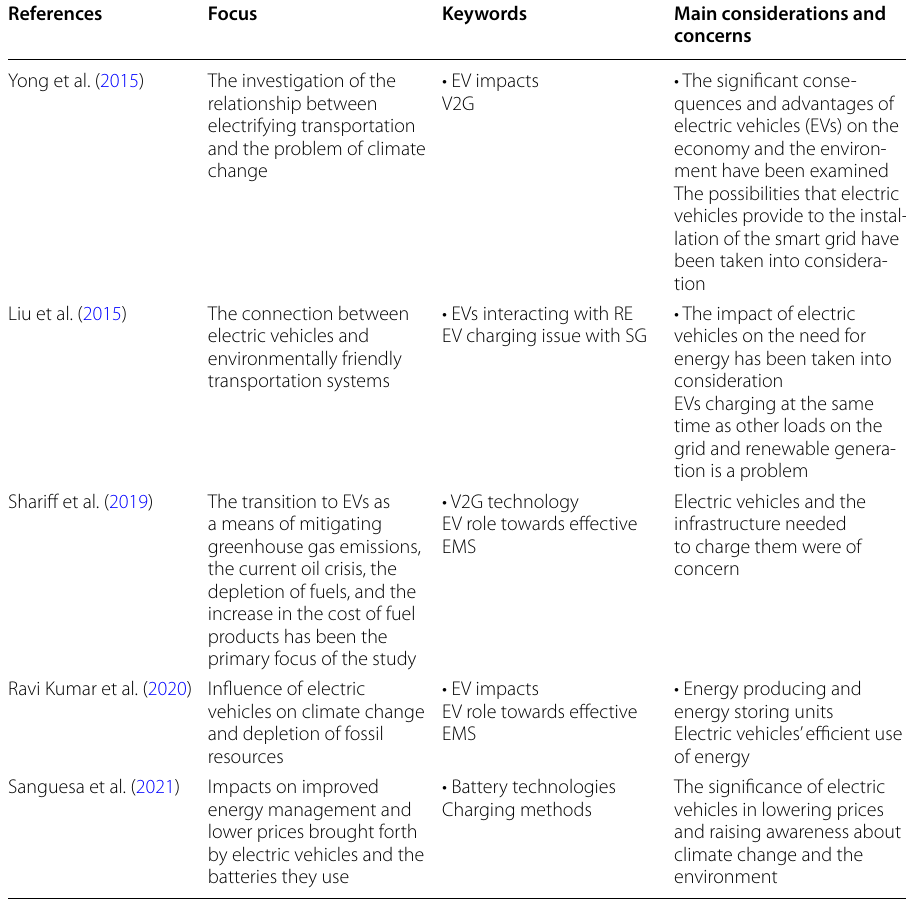
Table 1 A summarized overview of existing assessments’ focus, keywords, and main considerations and